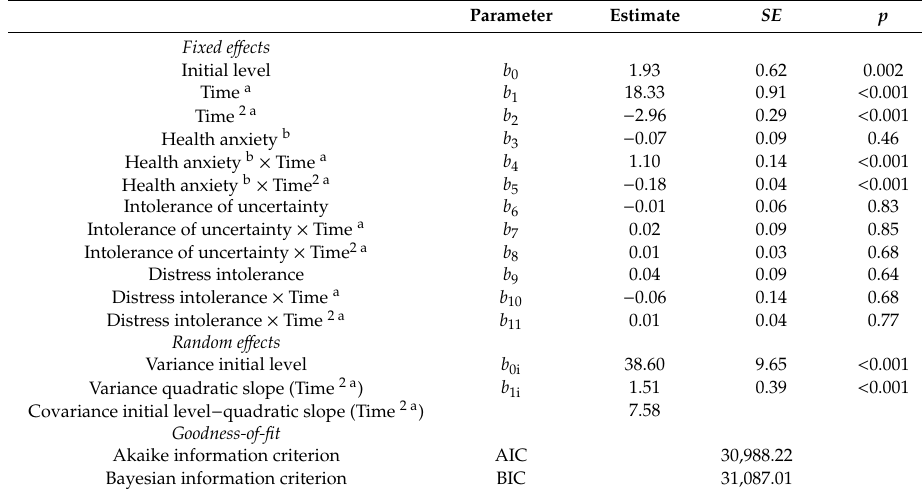
Table 3. Results of the conditional (including time-varying health anxiety [SHAI] and time-invariant intolerance of uncertainty [IU-18] and distress intolerance [Distress intolerance scale]) growth model of SARS-CoV-2 related anxiety. Parameter